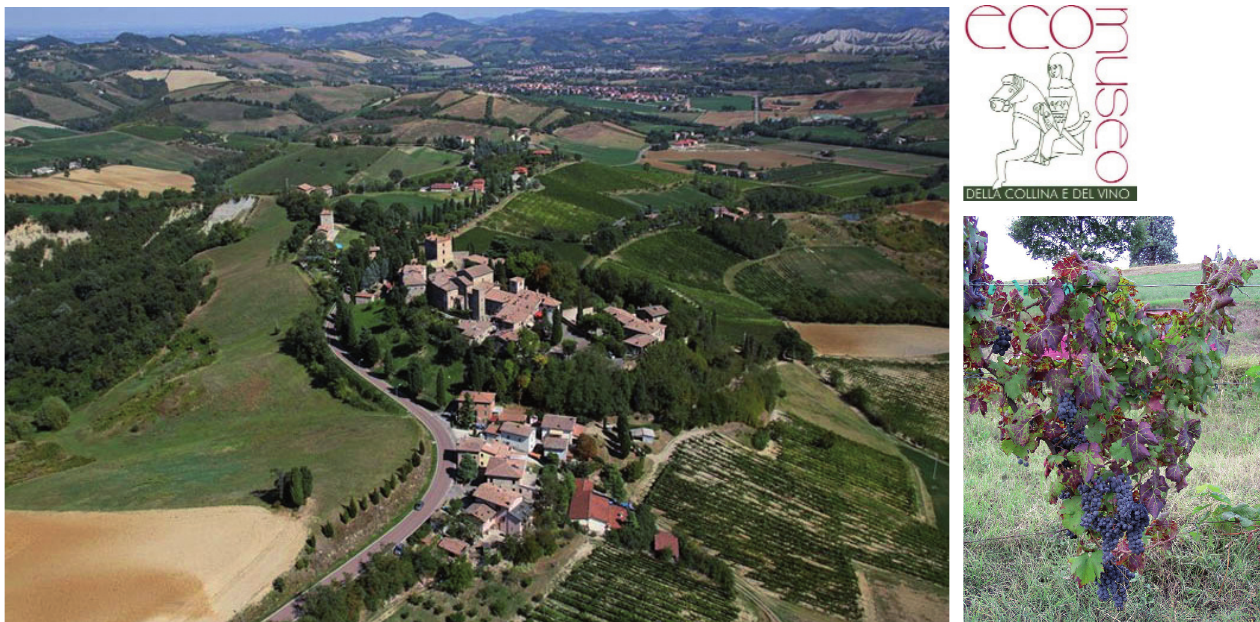
Figure 1. The landscape of Castello di Serravalle: a reciprocal interaction between man and the environment that has lasted over two